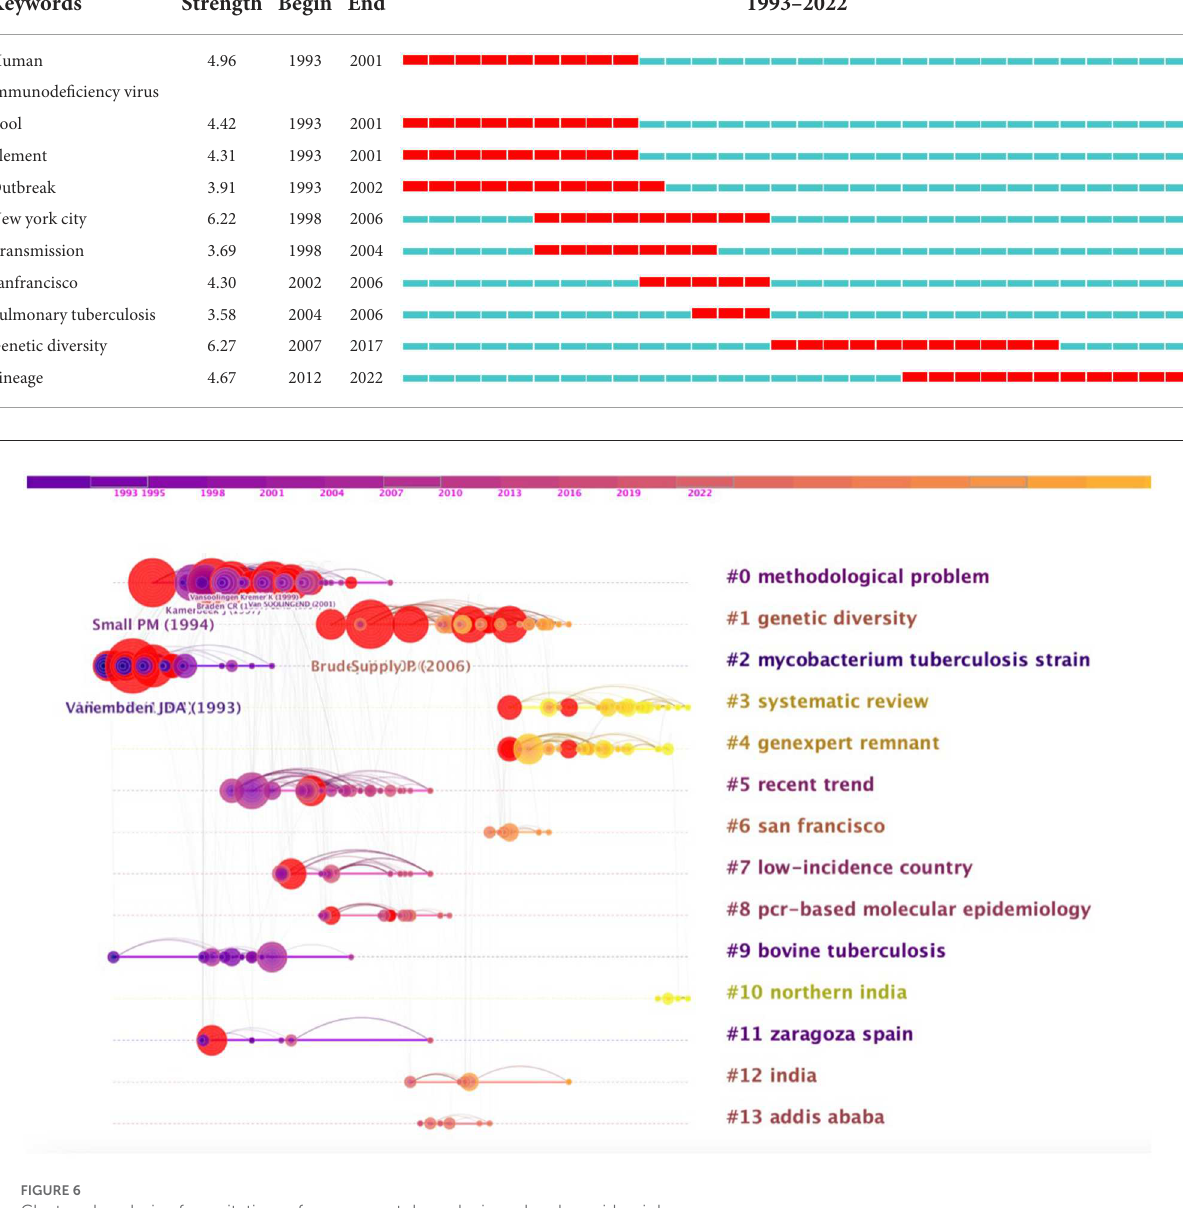
FIGURE6 Clustered analysis of co-citation references on tuberculosis molecular